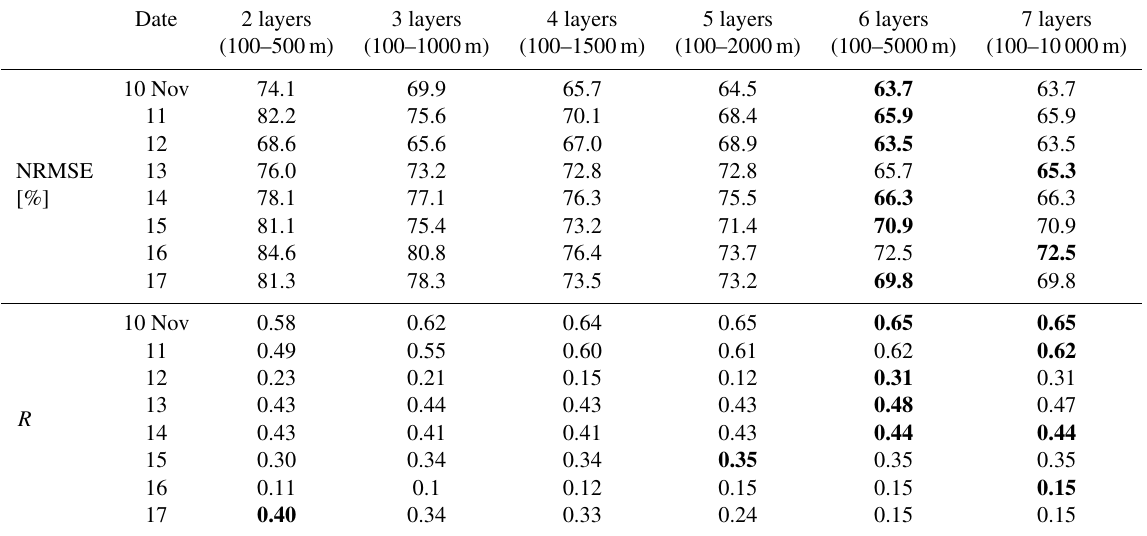
Table 3. Sensitivity tests for selection of two to seven layers among 100, 500, 1000, 1500, 2000, 5000, and 10000m. Beginning from two layers at 100 and 500m, the next higher layer is added for each test. The best performance is marked in bold.